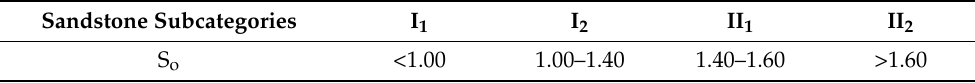
Table 8. The sorting coefficients of four subcategories of sandstone.